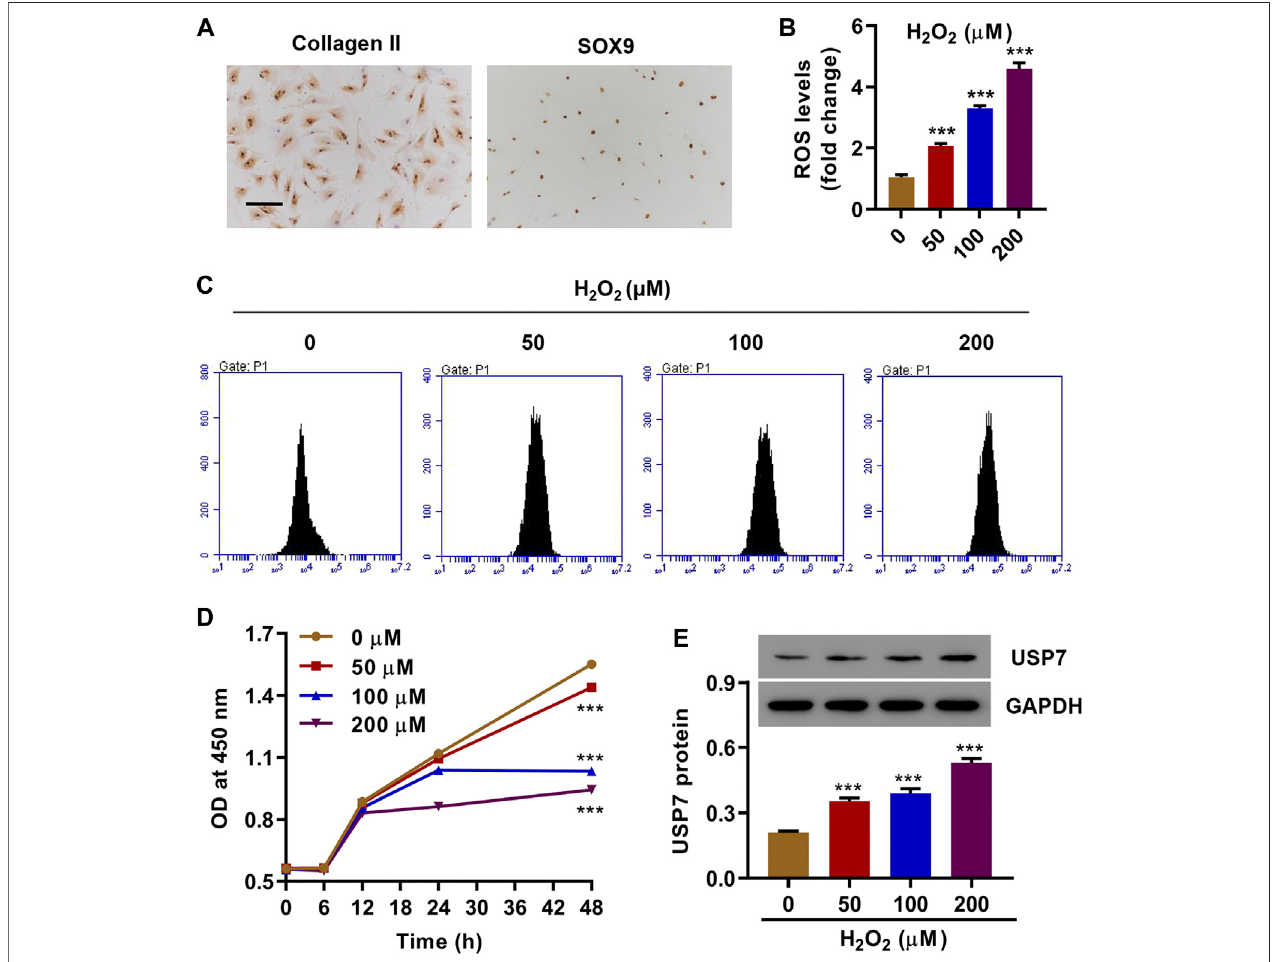
FIGURE1| H 2 O 2 increasedUSP7expressionandcauseddamageinratchondrocytes. (A) RepresentativeimmunohistochemicalstainingforcollagenIIandSOX9 in rat chondrocytes. Rat chondrocytes were treated with different concentrations of H 2 O 2 ; (B,C) ROS production, (D) cell proliferation, and (E) USP7 expression was measured by fl ow cytometry, CCK8, and Western blot, respectively. Scale bar, 100 μ m *** p < 0.001 vs. 0 μ M.